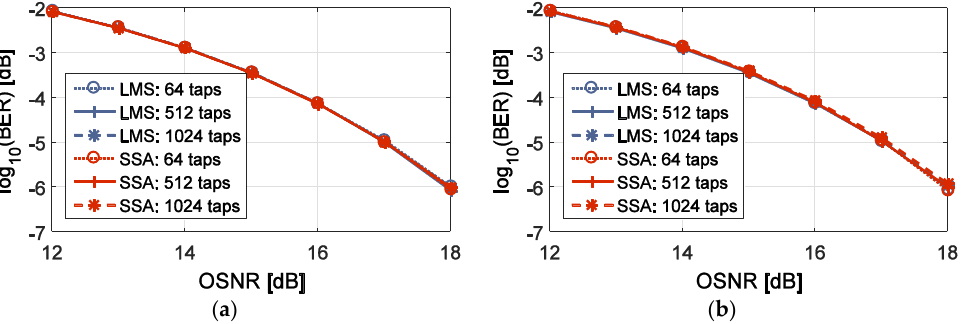
Figure 6. BER performance of different MIMO algorithms. ( a ) BER vs. OSNR for FD 2 × 2 LMS and SSA and ( b ) for FD 6 × 6 LMS and SSA.